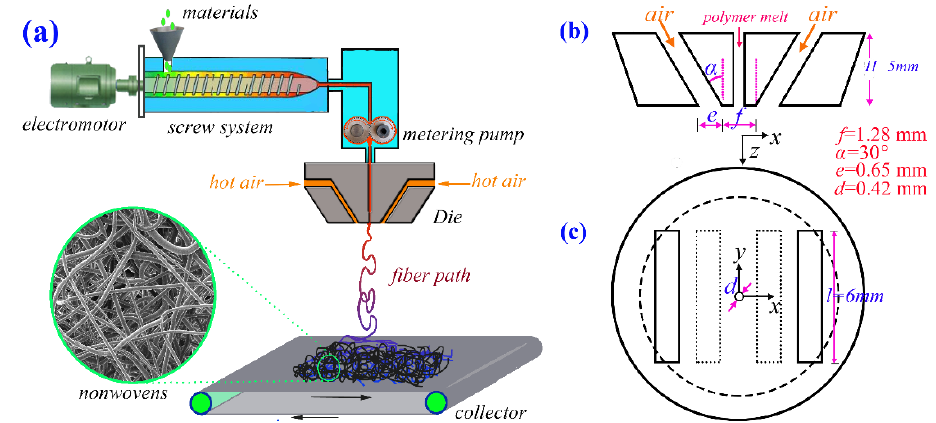
Figure 1. ( a ) Schematic process of the slot-die melt blowing. ( b ) Section view and ( c ) top view of the slot die used in the present work. The dot-lines in ( c ) are on the die face. This slot die is called “spinning die” in this work.